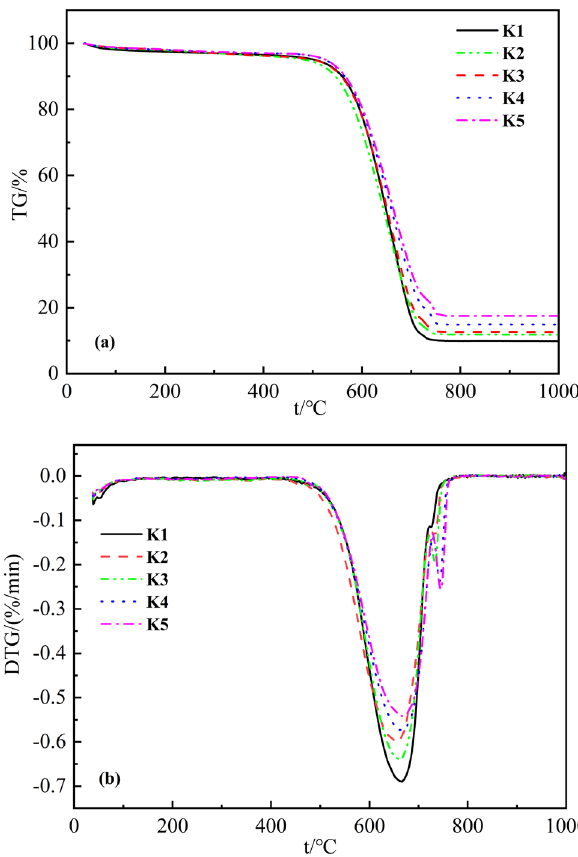
Figure 1: TG – DTG curves of the sample at the temperature rise rate of 20°C/min: ( a ) TG and ( b ) DTG